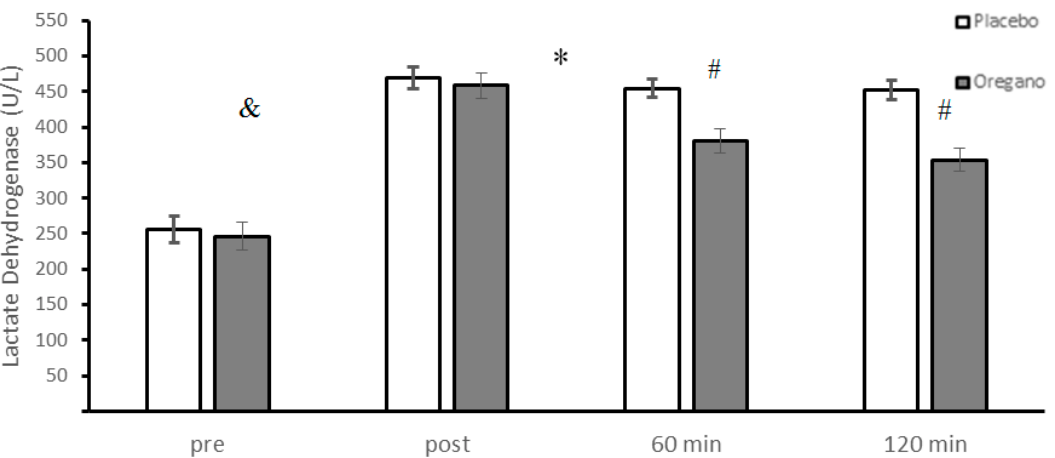
Figure 3. Mean ± standard deviations (SD) of plasma LDH levels before and at different times after consuming oregano supplements. The asterisk (*) indicates significant time × group interaction, (#) indicates significant difference between the two groups, and (&) indicates the main effect of time ( p < 0.05).